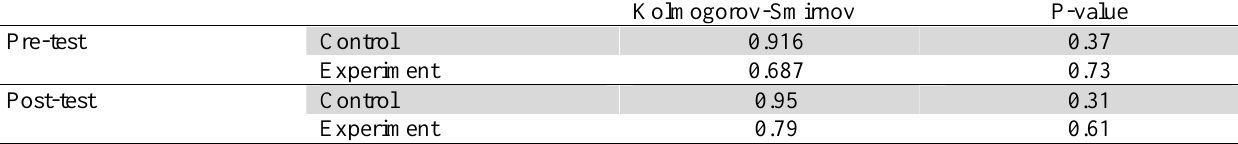
The summary of performing normality test using